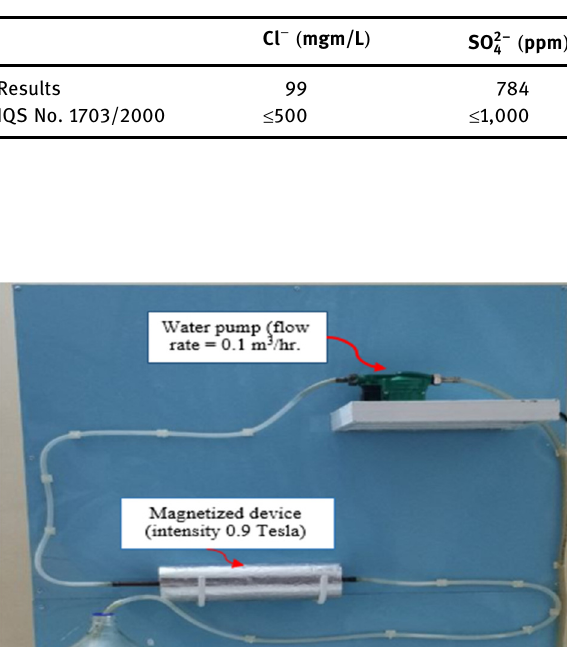
Table 6: Water properties